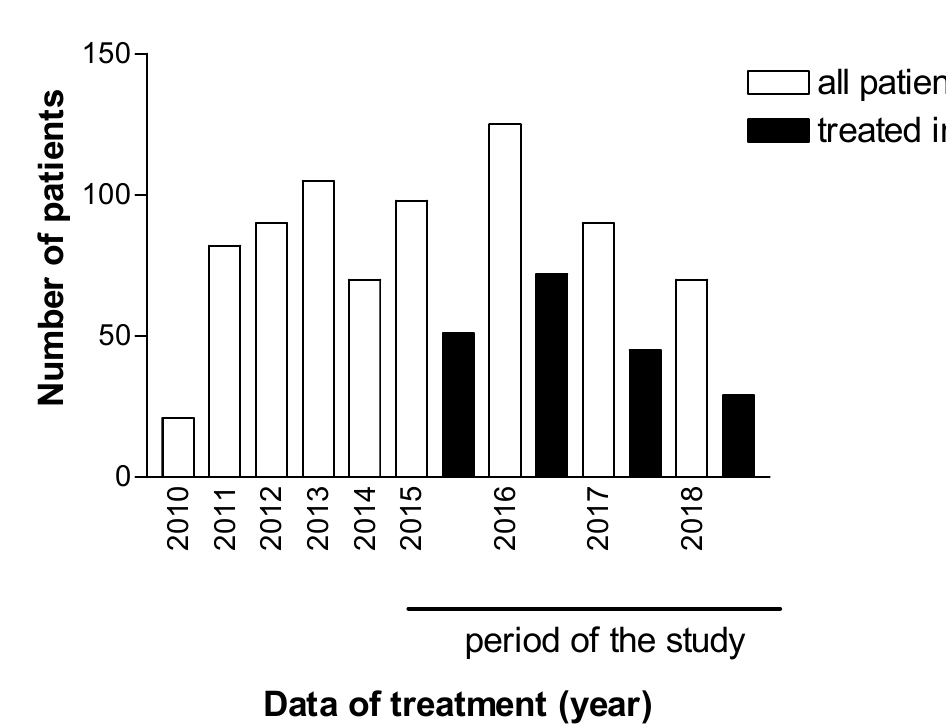
Figure 3. Patients diagnosed with HCV from the RHAN11 mesoregion and patients whose treatment was dispensed by the pharmacy of the Specialist Medical Clinic of Presidente Prudente and treated in the Regional Hospital (RH) of Presidente Prudente, S ã o Paulo,